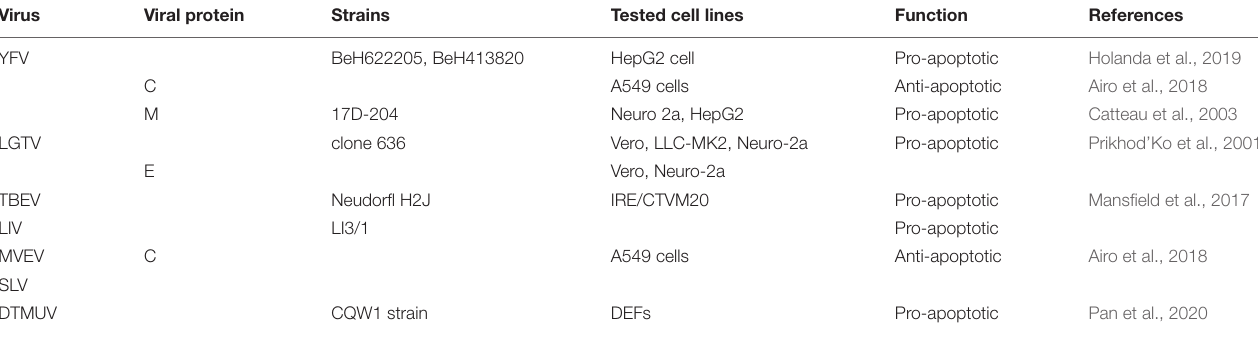
TABLE 5 | Pro-apoptotic or anti-apoptotic activity of other flavivirus and its proteins. Virus Viral